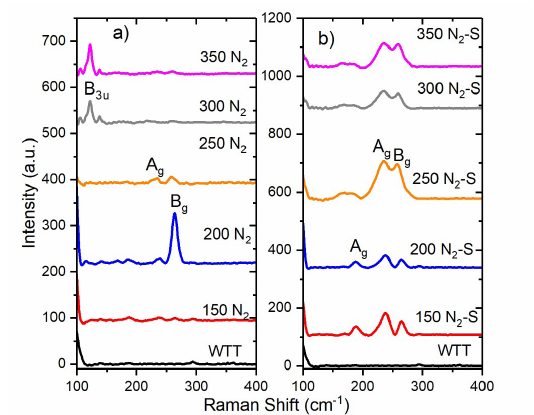
S films grown by PVD a) annealed 2 3